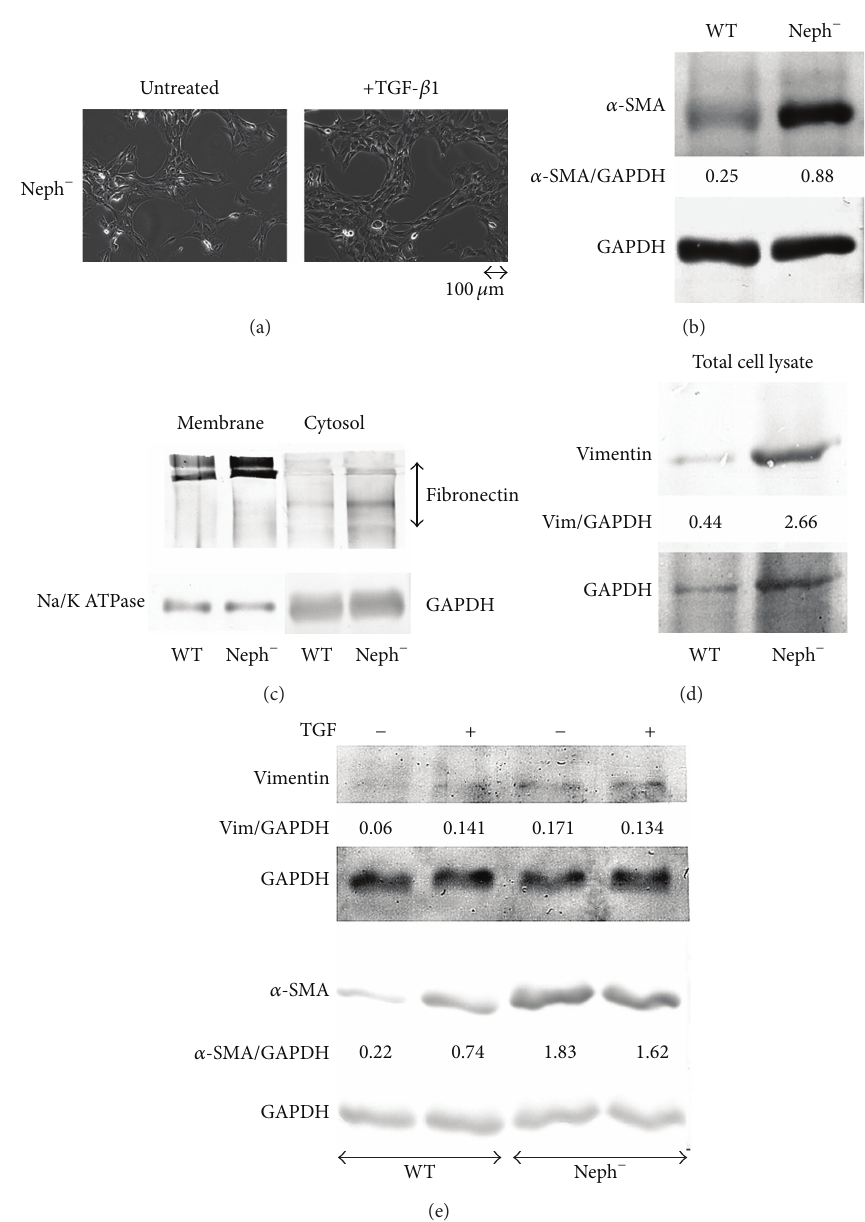
Figure 3: Phenotypic features of nephrin-mutated podocytes and EMT marker expression in human wild type and nephrin-mutated podocytes: effects of TGF- 𝛽 1 treatment. (a) The cells were grown as indicated in Section 2. Prior to the TGF- 𝛽 1 incubation (a) and (e), the cells were starved for 48hr. The pictures show the cells after 48 hr of TGF- 𝛽 1 treatment used at 5ng/mL. The optical images were obtained with a Will (Wetzelar) inverted microscopy at a 10x enlargement. (b) 𝛼 -SMA detection in wild type (WT) and nephrin deprived human podocytes (Neph − ). The anti- 𝛼 -SMA mouse monoclonal antibody was purchased from Sigma-Aldrich (St. Louis, MO, USA). (c) Detection of fibronectin bound to the membrane fraction and in the cytoplasm. Na-K-ATPase- 𝛼 1 was used as cell membrane marker to normalize the protein loading. Mouse monoclonal anti-fibronectin (sc-18825), goat anti-Na-K-ATPase- 𝛼 1 (sc-16041) polyclonal antibodies were purchased from Santa Cruz Biotechnologies (Santa Cruz, CA, USA). (d) Detection of vimentin in the total cell lysate. The goat anti-vimentin (sc-7557) was purchased from Santa Cruz Biotechnologies (Santa Cruz, CA, USA). (e) Effects of TGF- 𝛽 1 on vimentin and 𝛼 -SMA expression in the indicated podocyte cells. To quantify the protein bands, we scanned the blots and performed a densitometry analysis, using the software NIH ImageJ v. 6.4 (freeware, NIH, MD, USA). The figure shows a typical experiment of at least three performed under the same